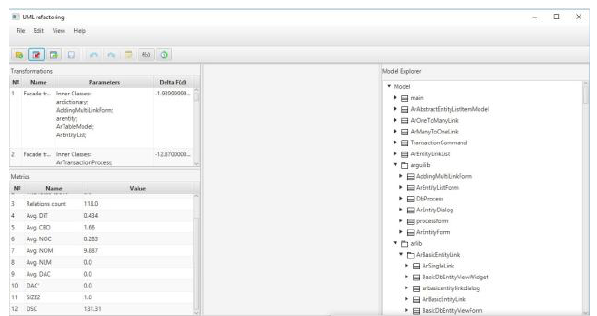
Fig. 13. Performance of the DSC Metric Calculation Algorithm The fitness function selection window is shown in Fig. 14.